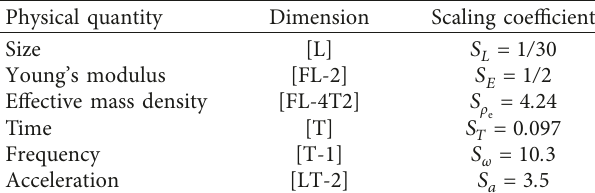
Table 1: Detailed similarity